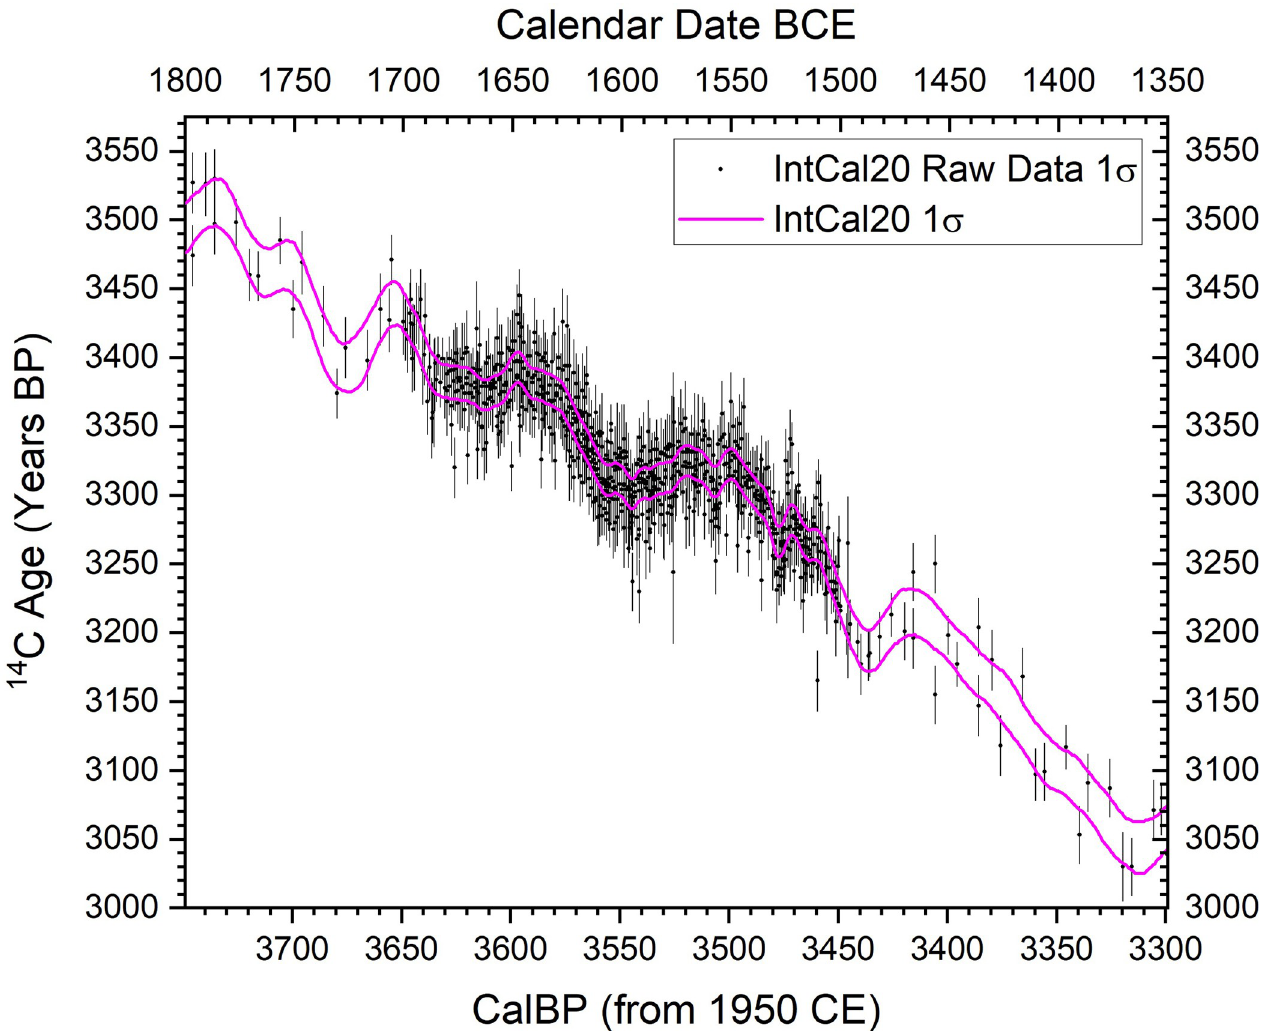
Fig 1. IntCal20 modelled 14 C calibration curve (1 σ ) and the raw 14 C data (1 σ ) used to compile this curve showing the period 1800–1350 BCE [41]. The notable density of data available for the interval 1700–1500 BCE is evident (most new as part of IntCal20), as also the much better definition that is therefore available for the modelled IntCal20 curve over this period. The constituent IntCal20 dataset is available from: http://intcal.org/.